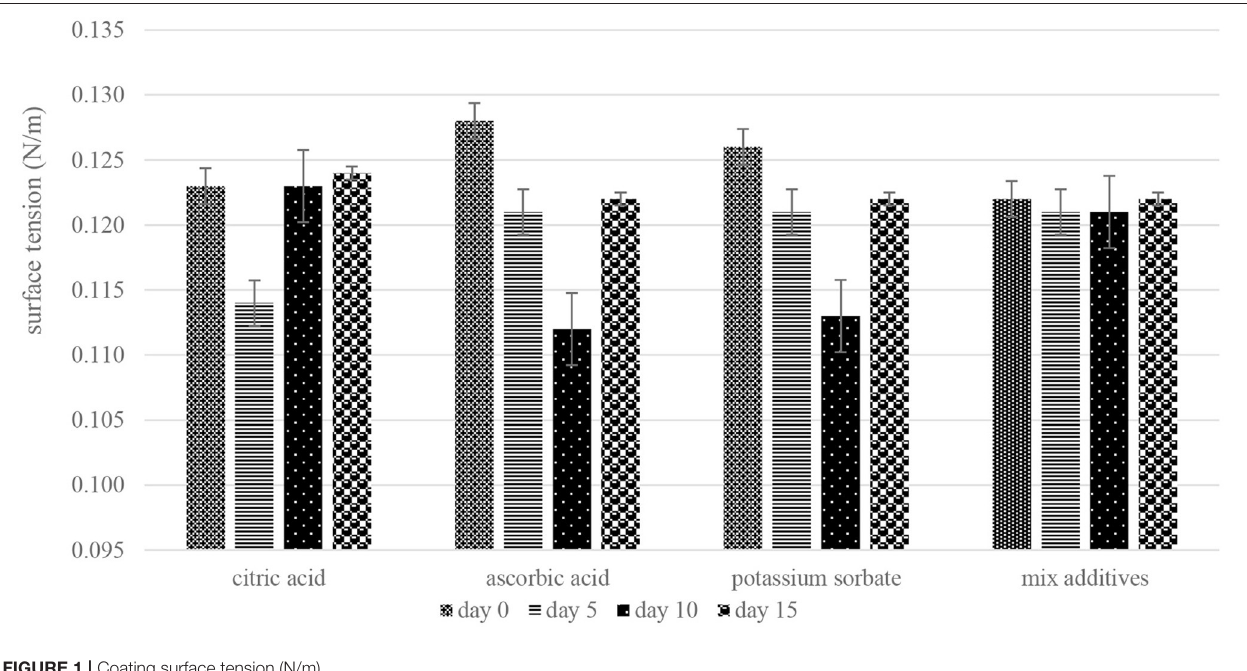
FIGURE 1 | Coating surface tension (N/m).